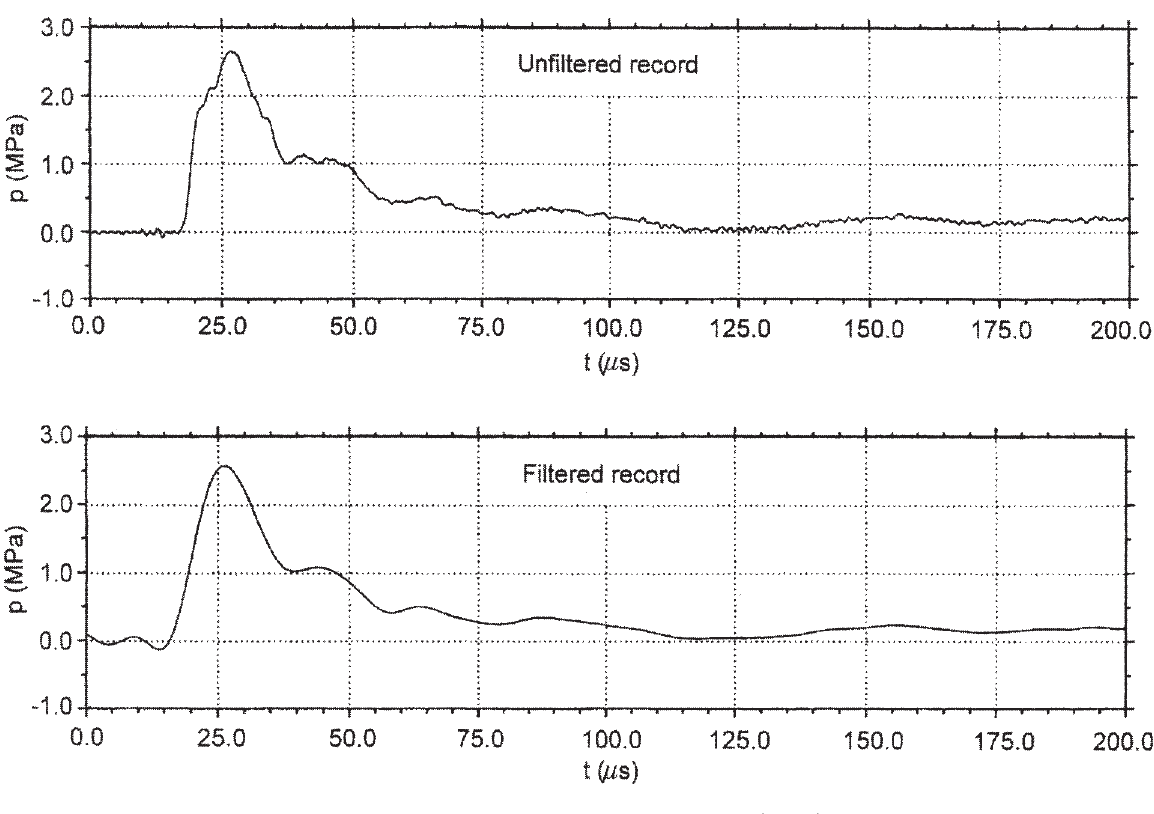
Fig. 8. Effect of filtering on a typical pressure record (gage